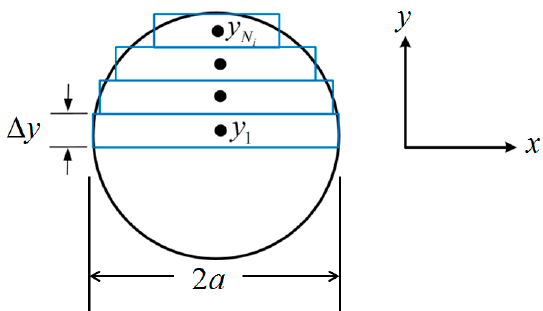
Figure 6. Discretized SMA cross-sectional area.